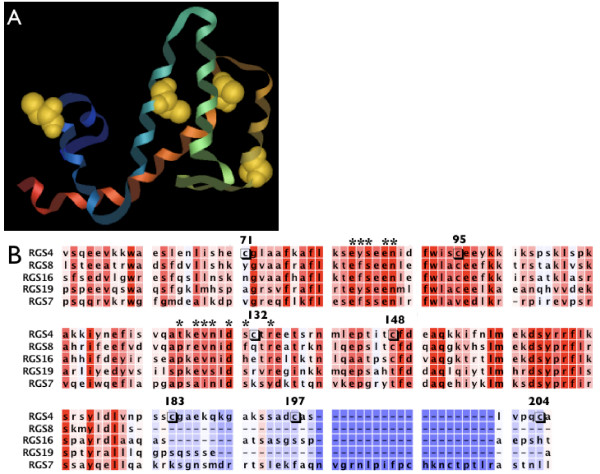
RGS alignment. A) The structure of the RGS4 domain [3] with the cysteines highlighted. B) An alignment of the RGS proteins used in Figure 3 compared to the RGS4Δ51N construct. The RGS proteins are listed in order of inhibition by 5nd. The red residues are conserved and the blue are not. The stared residues are important for Gα interactions and the cysteines in RGS4 are boxed.